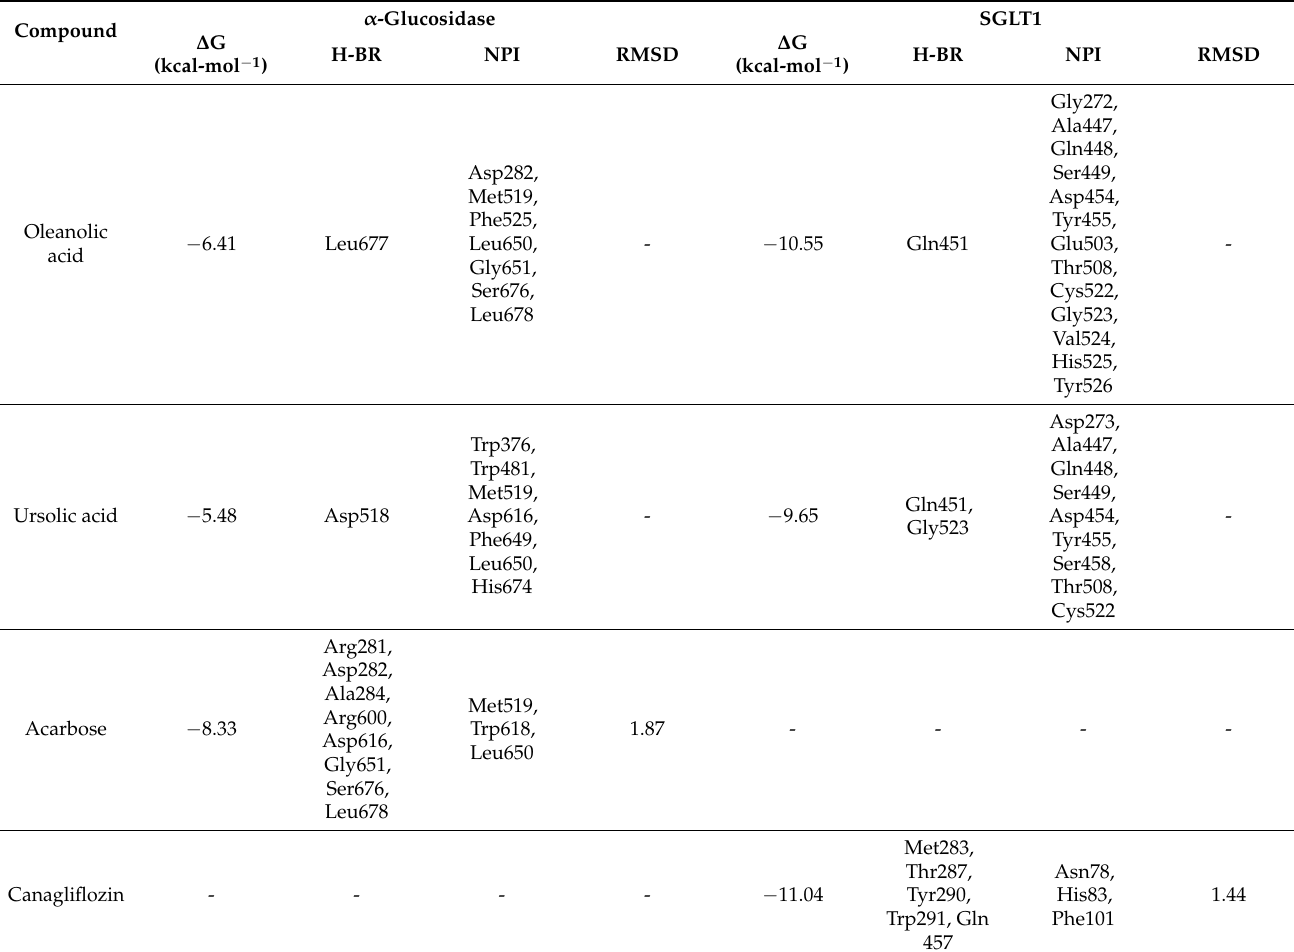
Table 5. Interactions of oleanolic acid ( OA ), ursolic acid ( UA ) acarbose and canagliflozin with residues on the binding sites of α -glucosidase and SGLT1